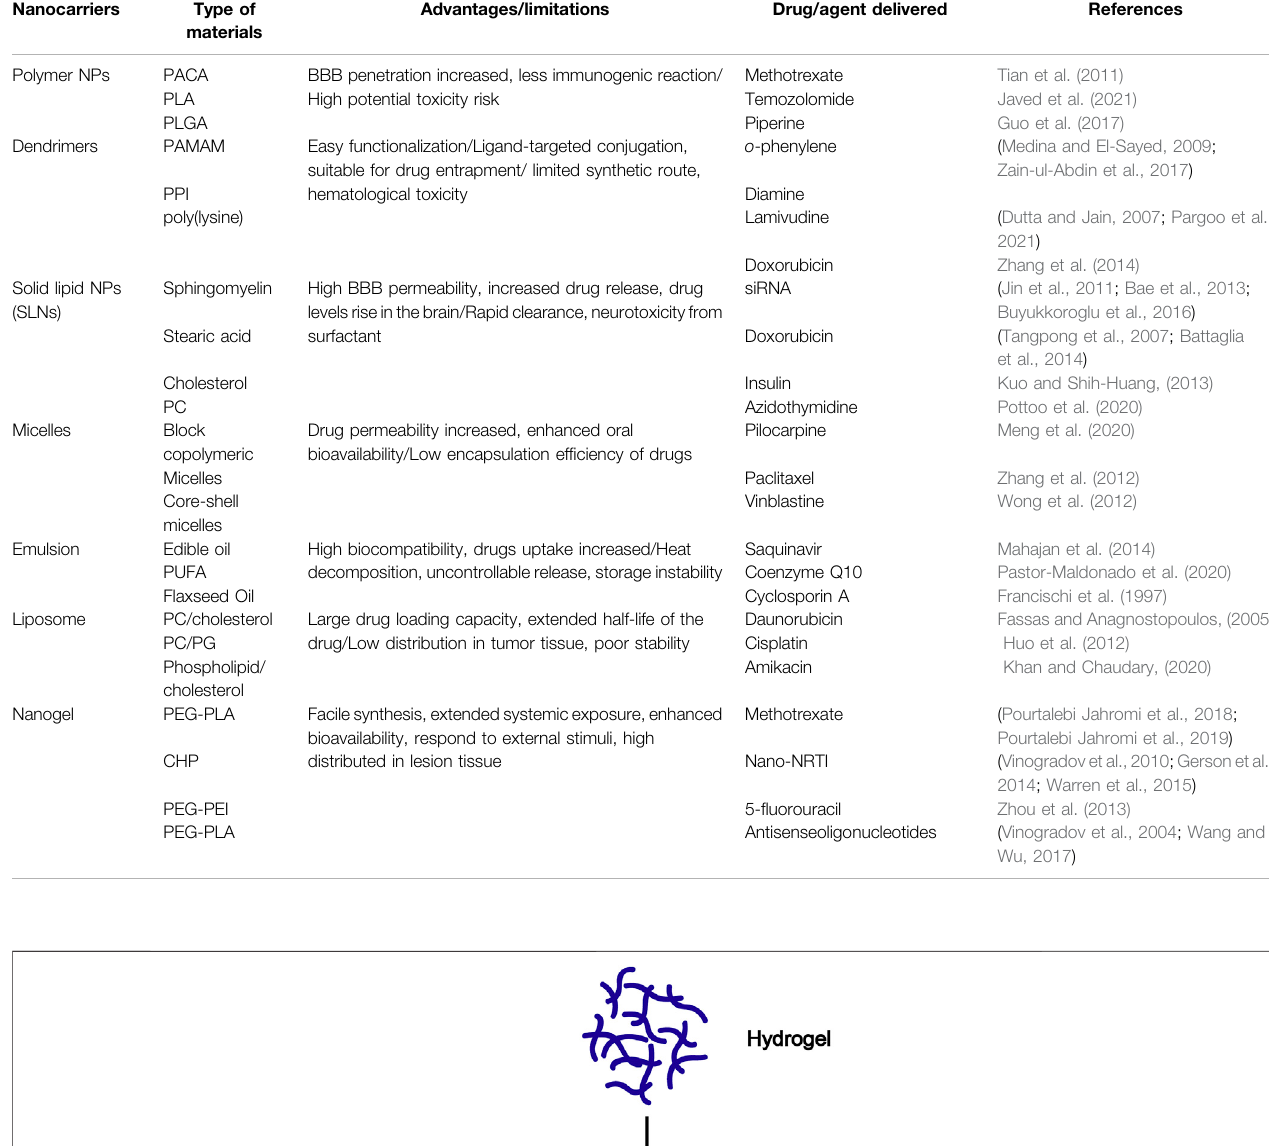
TABLE 1 | A brief list of properties for nanocarriers used in the fi eld of CNS therapeutics. Nanocarriers